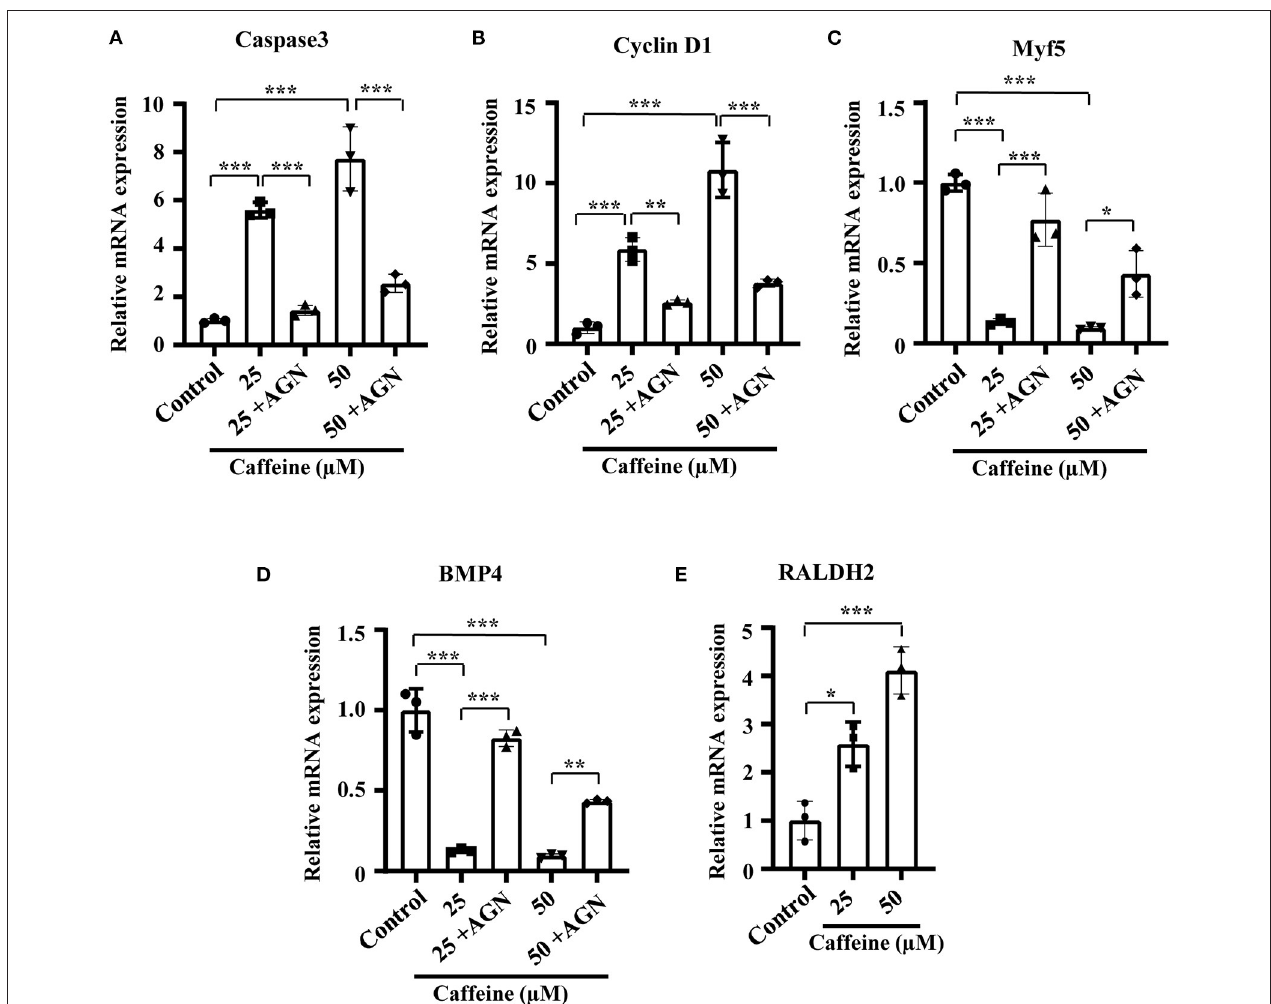
FIGURE 6 | Quantitative RT-PCR data of Caspase3 (A) , Cyclin D1 (B) , Myf5 (C) , RALDH2 (D) , and BMP4 (E) in C2C12 cells after caffeine treatment and blockage of retinoic acid (RA) signaling. * P < 0.05, ** P < 0.01, *** P < 0.001.